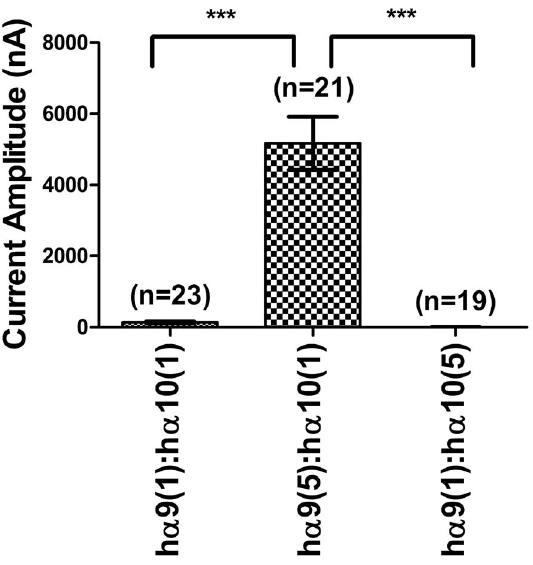
Figure 3. Comparison of functional receptor expression following injection of different ratios of receptor subunit cRNA. Differing subunit ratios of cRNA were injected into oocytes and the resulting levels of expression of functional receptors were compared. Recordings were performed 2 days after injection. The data from oocytes of four different batches were combined to determine the mean current amplitudes. Values are given in Table 2. A one-way ANOVA test with Tukey’s post-hoc comparison indicated a significant difference between h a 9(1):h a 10(1) vs. h a 9(5):h a 10(1), p , 0.001, and between h a 9(5):h a 10(1) vs. h a 9(1):h a 10(5), p , 0.001. There was